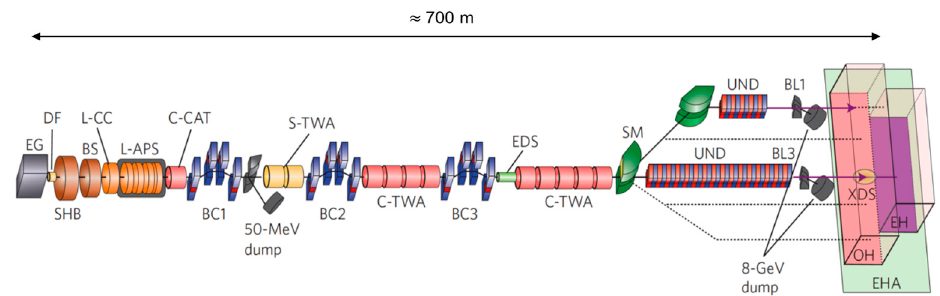
Figure 5. Schematic of SACLA: a compact XFEL. EG, 500 keV electron gun; DF, deflector with collimator; SHB, 238 MHz subharmonic buncher; BS, 476 MHz booster; L-CC, L-band correction cavity; L-APS, L-band alternating periodic structure (APS) typed standing-wave cavity; C-CAT, C-band correction acceleration tube; S(C)-TWA, S(C)-band travelling-wave acceleration tube; BC n ( n ≈ 1–3), n th bunch compressor; EDS, electron beam diagnostic section; SM, switching magnet; UND, undulator line; BL n ( n = 1, 3), n th beam line; XDS, X-ray diagnostic system; EHA, experimental hall; OH, optical hutch; EH, experimental hutch. Only two beam lines beamlines (BL1 and BL3) were available in 2012. SACLA has the capability to install five independent FEL beamlines, and there are three currently in operation. Please refer to Reference [66] for details about each insertion device. Image adapted with permission from Springer Nature.